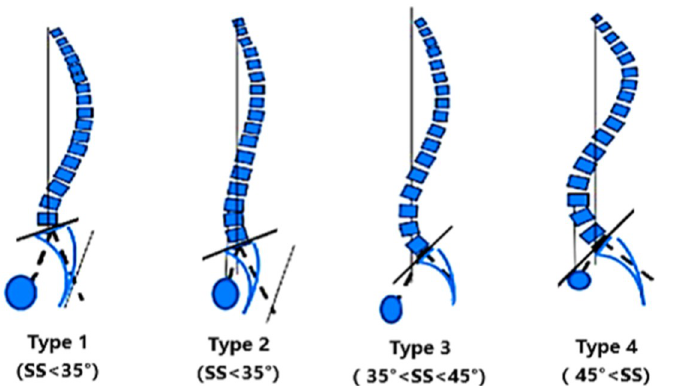
Fig 1. Schematic diagram of Roussouly’s 1–4